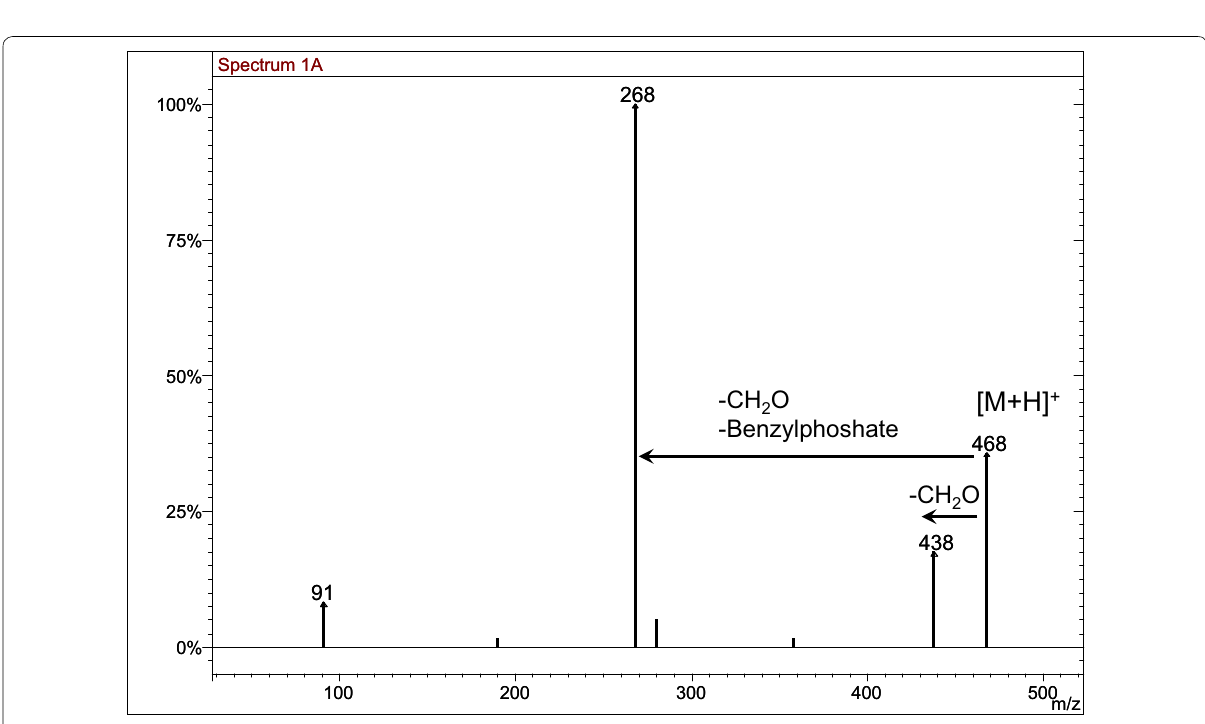
Fig. 7 MS/MS spectra of [M